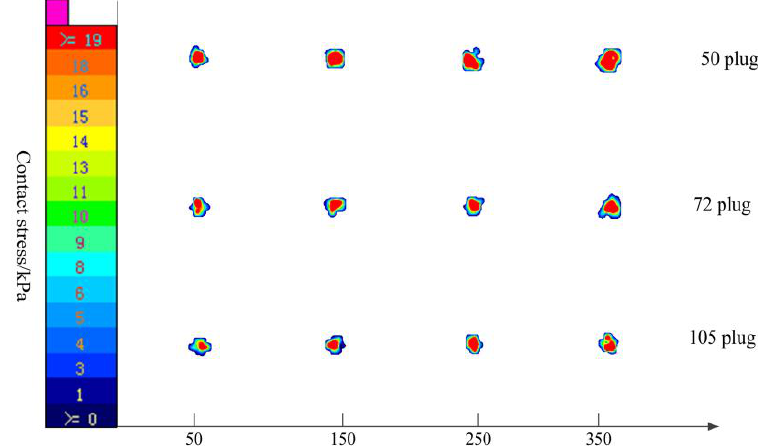
Figure 12. Typical stress distribution of oil sunflower seedlings of different plug specifications under different drop heights.